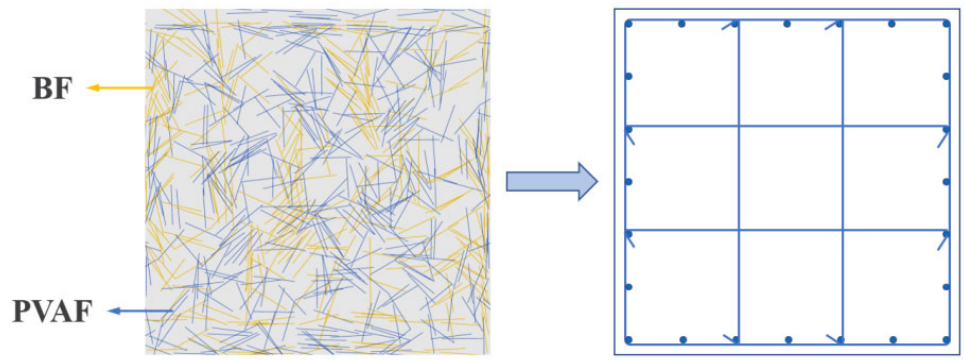
Figure 14. The working effect of force ‐ transmitting fiber micro ‐ rebar mesh is equivalent to that of hooped reinforcement.